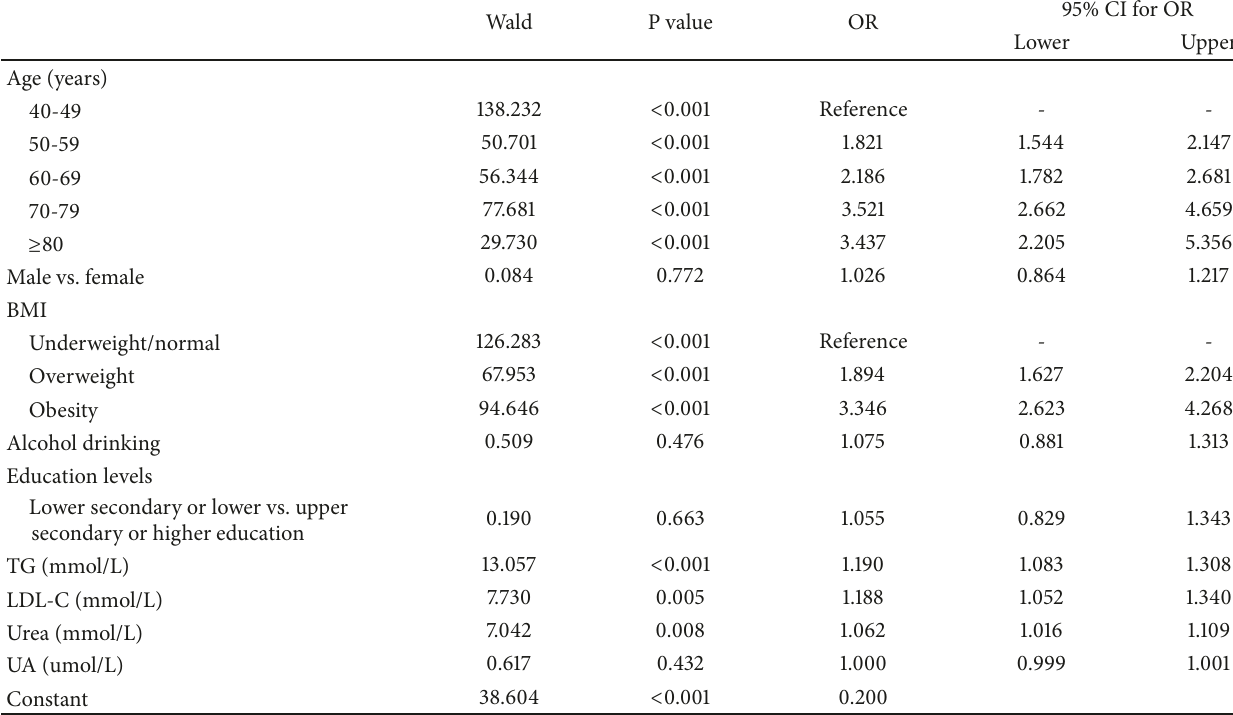
Table 9: Multivariate binary logistic regression analysis of risk factors of hypertension in rural